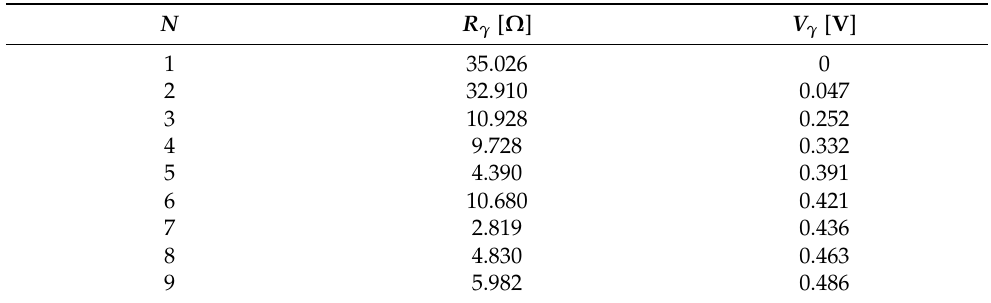
Figure 11. P-V curves using the 1M5P model and the proposed model, at T = 50 ◦ C. The last temperature is 60 ◦ C and the I-V curves of both models are presented in Figure 12. The 1M5P computed parameters were I L = 0.248 A, I o = 1.067 × 10 − 13 A, n = 0.631, R sh = 35.687 Ω and R s = 0.424 Ω and the parameters for the d1MxP are shown in Table 4. As expected, the d1MxP ( x = 18) model fitting is more accurate than the 1M5P curve. The P-V curves are in Figure 13 corroborating the previous conclusions. Table 4. Quantitative values computed for the branches connected in parallel, for T = 60 ◦